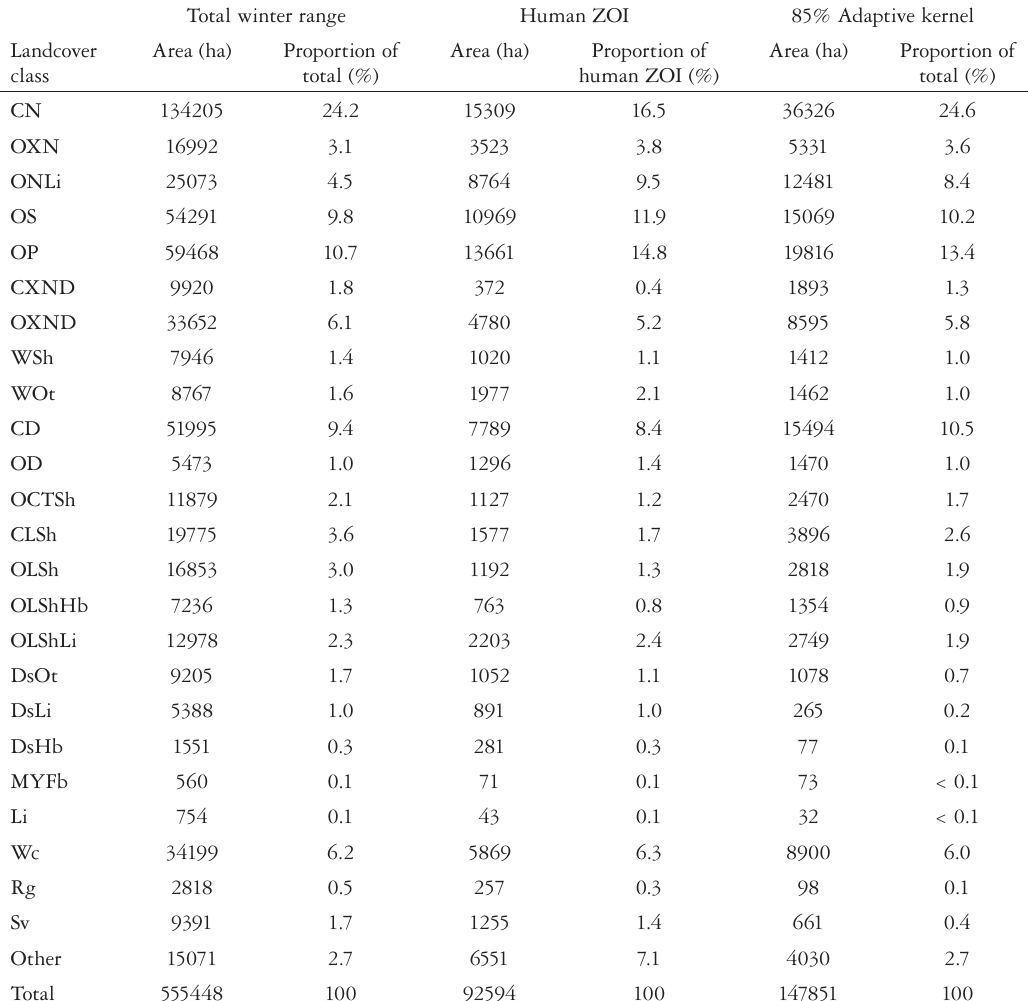
Table 2. Distribution (area and %) of land cover classes (Ducks Unlimited, 2002) over the Carcross caribou herd winter range, within the human Zone Of Influence, and the 85% Adaptive Kernel.